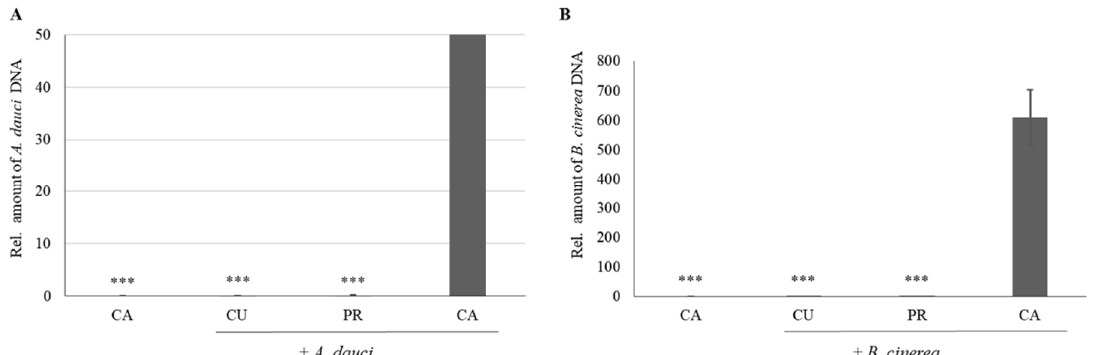
Figure 4. Quantification of fungal DNA in carrot sprayed with fungal conidia. The relative amount of DNA was quantified by qPCR. ( A ) The relative amount of DNA ( Adgpd gene) of Alternaria dauci in carrot plants normalized with the carrot ubiquitin gene. ( B ) The relative amount of DNA ( β -tubulin gene ) of Botrytis cinerea in carrot plants normalized with carrot ubiquitin gene. Bars represent the standard deviation of three replicates and significant changes are marked: *** p < 0.001 (Student- test). PR = preventive; CU = curative; CA = control non-treated.